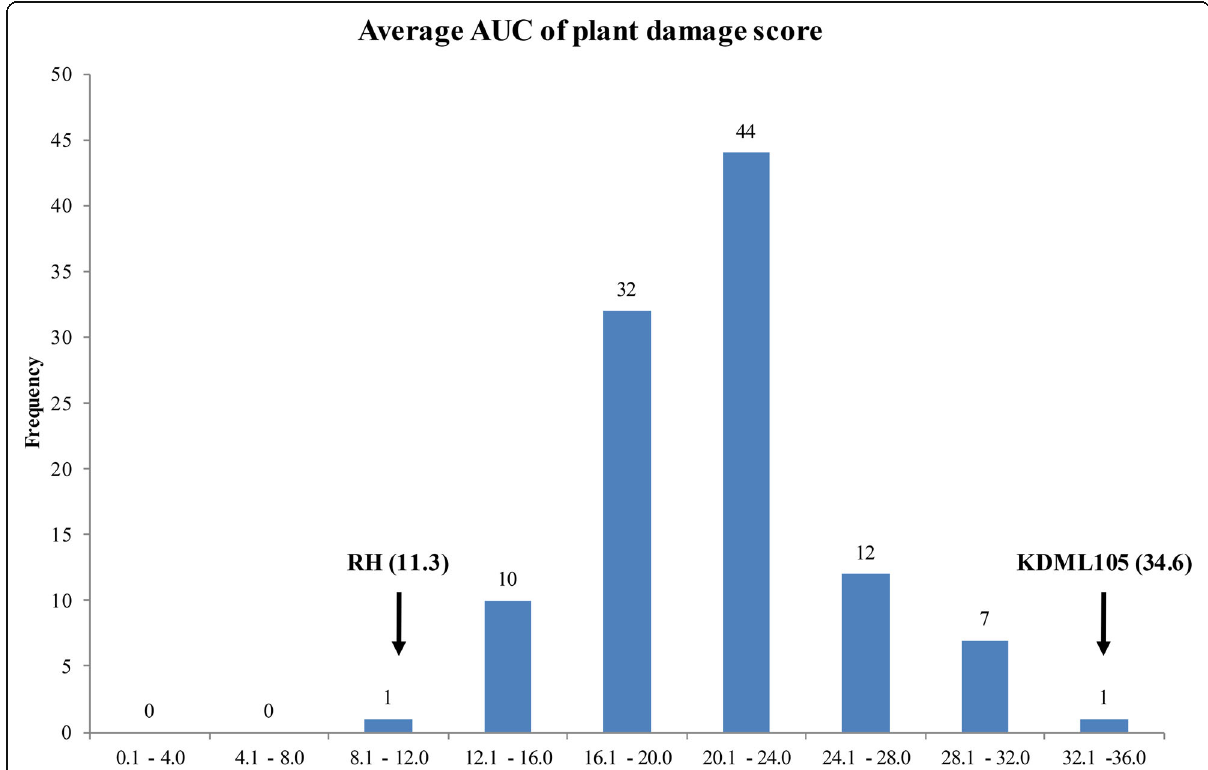
Fig. 1 Frequency distribution of average AUC of damage scores on BILs from 6 BPH